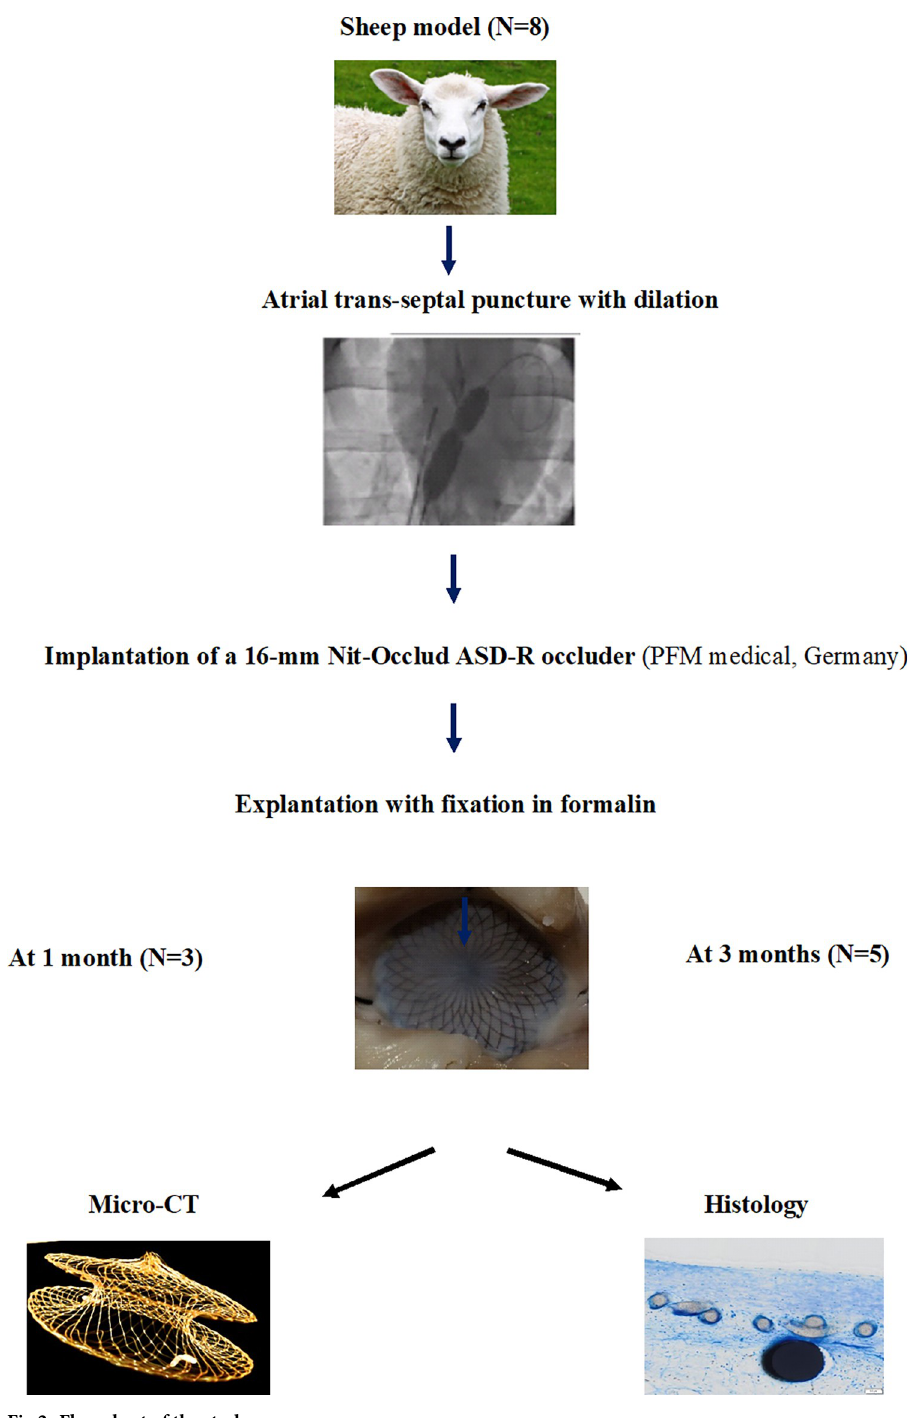
Fig 2. Flow chart of the